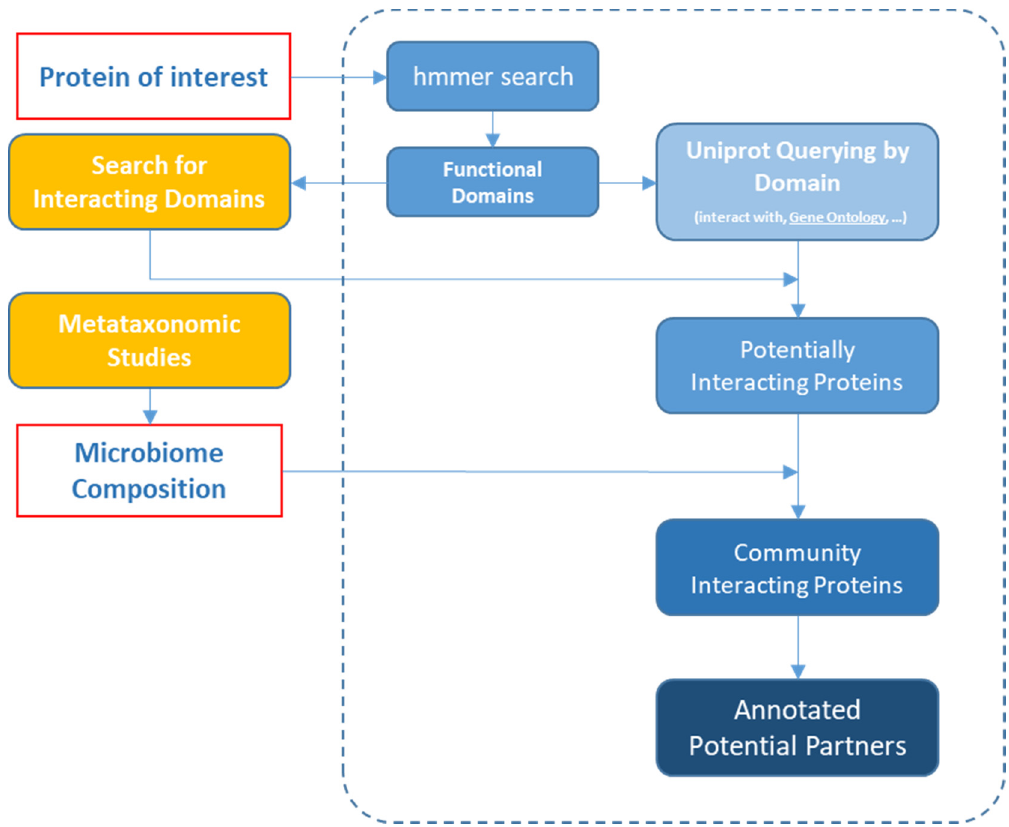
Figure 1. Implemented Analytical Workflow. A dedicated bioinformatic approach was developed to test in silico the possible interactions between a candidate protein and the microbiota proteome. The steps inside the dashed box represent the here implemented automatic workflow; data from the side (list of interactions and microbiome composition) have to be manually provided. A module for the automatic download of domain-domain interactions from the Pfam database is currently under development, but any alternative strategy can be applied to feed this automatic workflow.